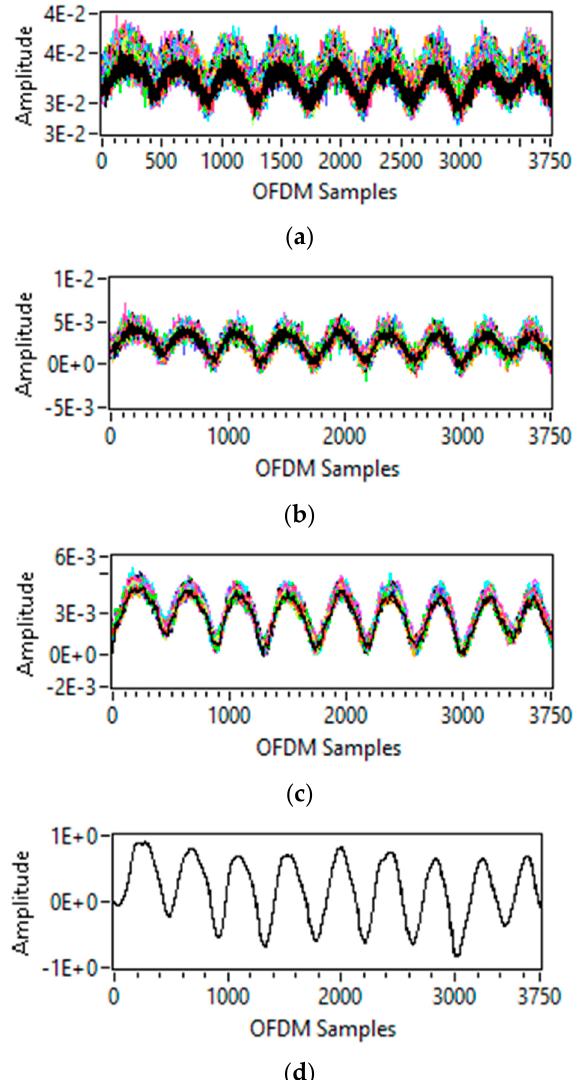
Figure 3. Data preprocessing: ( a ) subcarrier selection; ( b ) outlier removal; ( c ) smoothening; and ( d ) normalization .